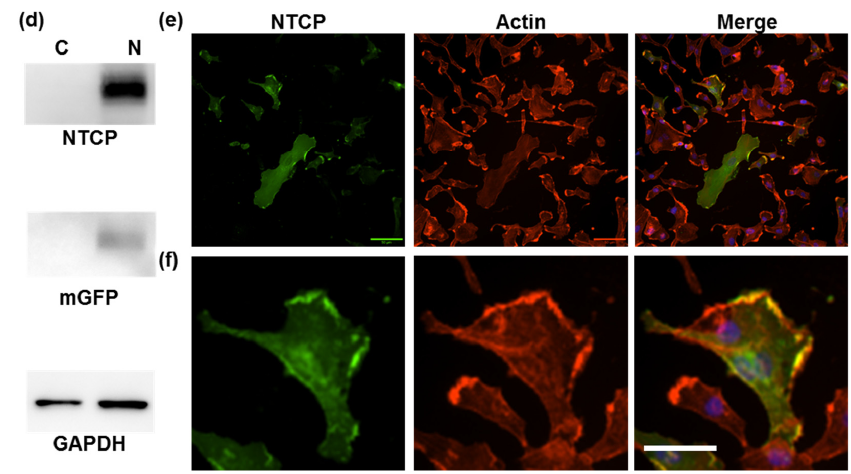
Figure 1. Overexpression of the apical sodium-dependent bile acid cotransporter (ASBT) and sodium taurocholate cotransporting polypeptide (NTCP). ( a , d ) Western blotting of ASBT, NTCP glyceraldehyde-3-phosphate dehydrogenase (GAPDH), and green fluorescent protein (GFP). ( b , e ) The location of ASBT, NTCP (green), actin (red), and nucleus (blue) in cells expressing ASBT at a lower magnification. Scale bar: 50 μ m. ( c , f ) The location of ASBT, NTCP (green), actin (red), and nucleus (blue) in cells expressing ASBT at a higher magnification. Scale bar: 25 μ m. C: control cells. A: cells expressing ASBT. N: cells expressing NTCP.